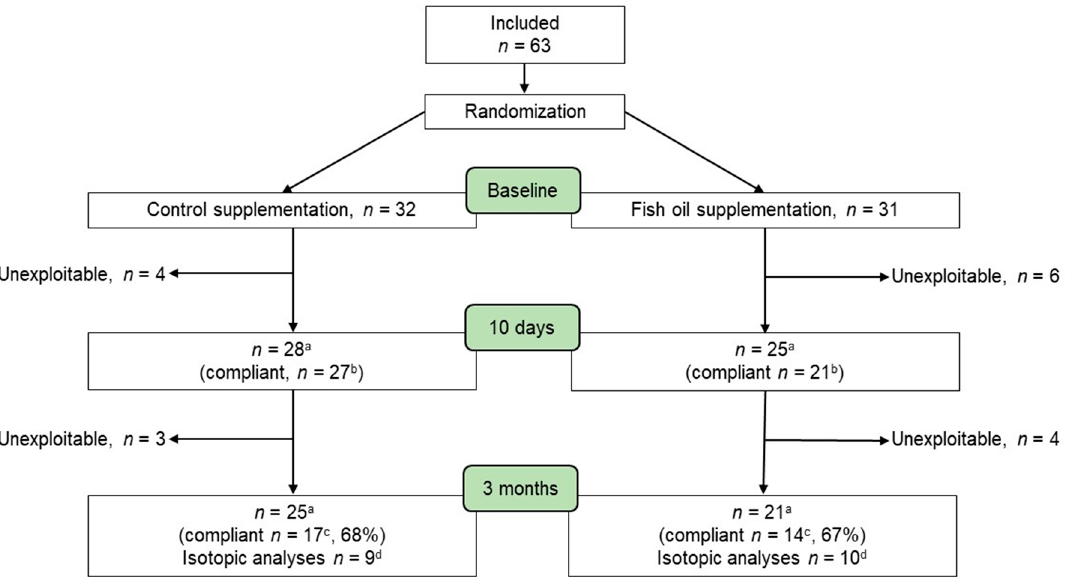
Figure 2. Study participant flow chart. Unexploitable patients either withdrew from the trial, were excluded due to an early interruption of chemotherapy, or had a missing sample. a Sample used for the analyses of the changes in plasma fatty acids presented in Figure 3. b Sample of compliant patients used for the partial least squares discriminant analysis. c Sample of compliant patients used for the kinetic analyses of plasma fatty acids and cytokines. d Compliant patient subsample used for the isotopic